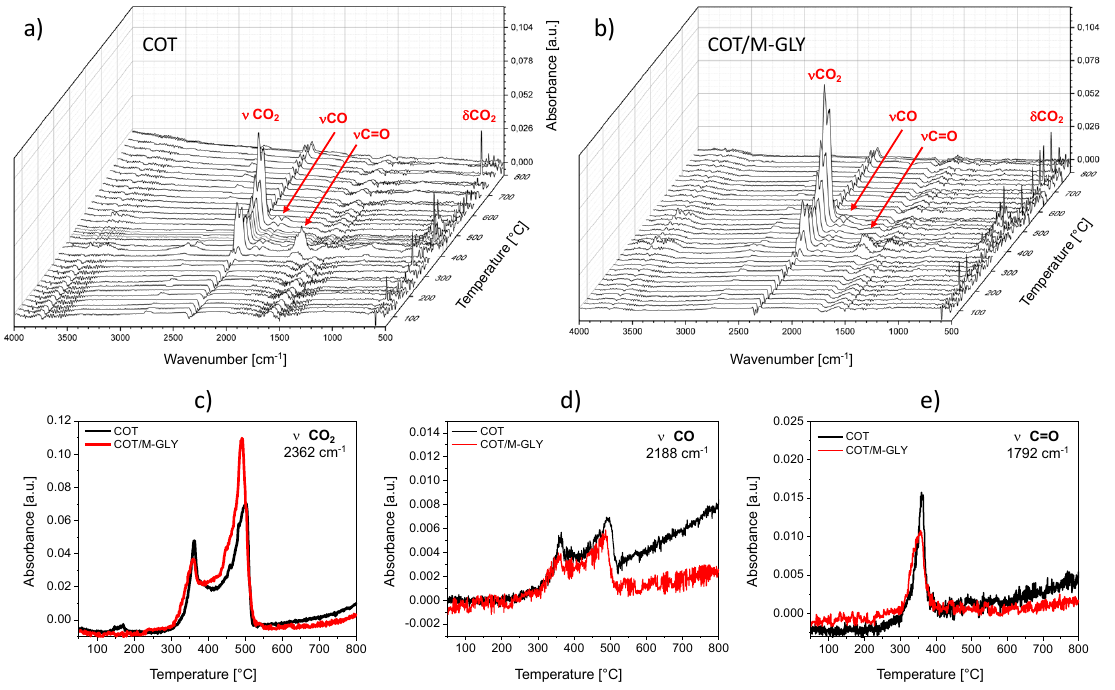
Figure 2. 3D plots of the FT-IR spectra of the volatiles released from untreated cotton ( a ) and 4% add-on M-GLY-treated cotton ( b ) within the temperature interval 100–800 ◦ C in air. Temperature dependence of the carbon dioxide (CO 2 ), carbon monoxide (CO) and carbonyl compounds (C=O) ( c – e ) release within the same temperature interval.